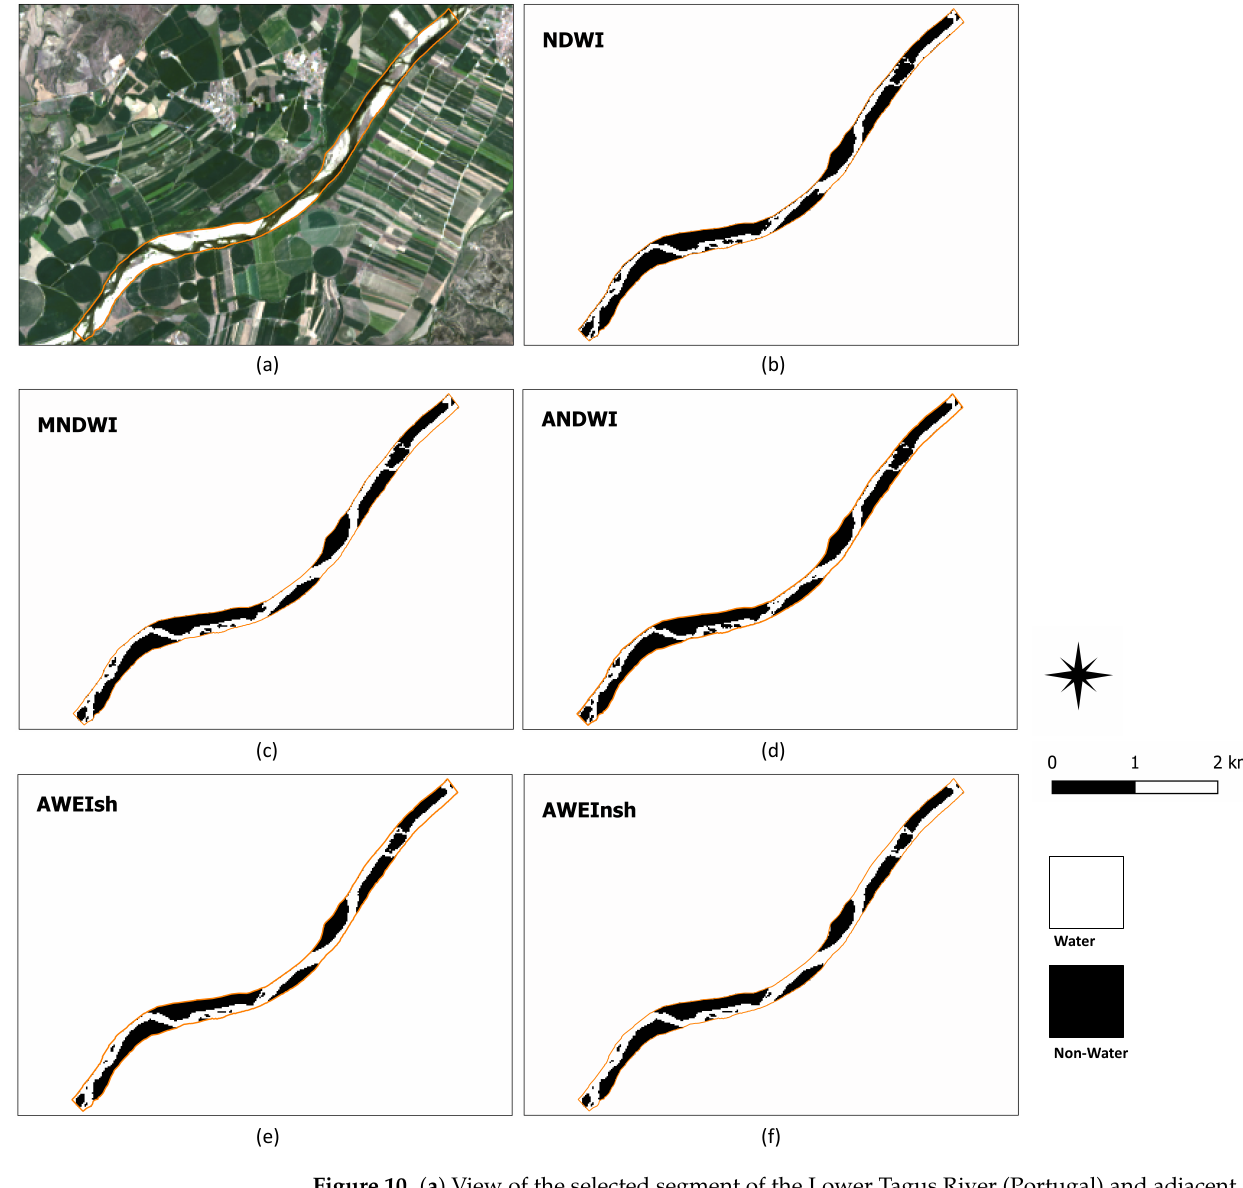
Figure 10. ( a ) View of the selected segment of the Lower Tagus River (Portugal) and adjacent areas. ( b – f ) Water and sandbar (non-water) mapping for the river segment based on the classification of water indices calculated using Landsat 9 data (7 July 2022). The class separation threshold was estimated by manual decision. Data resolution is 30